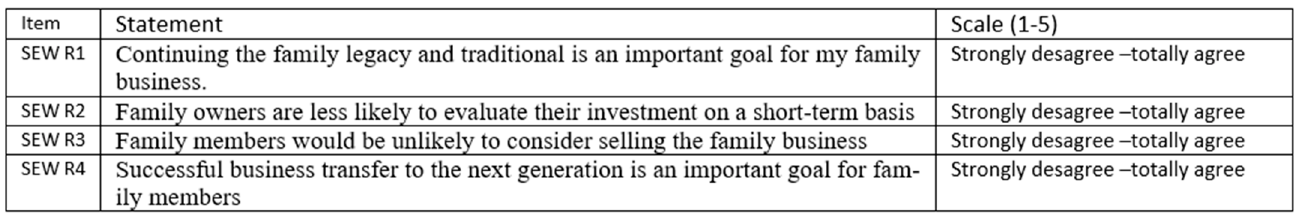
Figure 1. Statements and scales used for the measurable items that represent SEW dimension R. Source: [54].